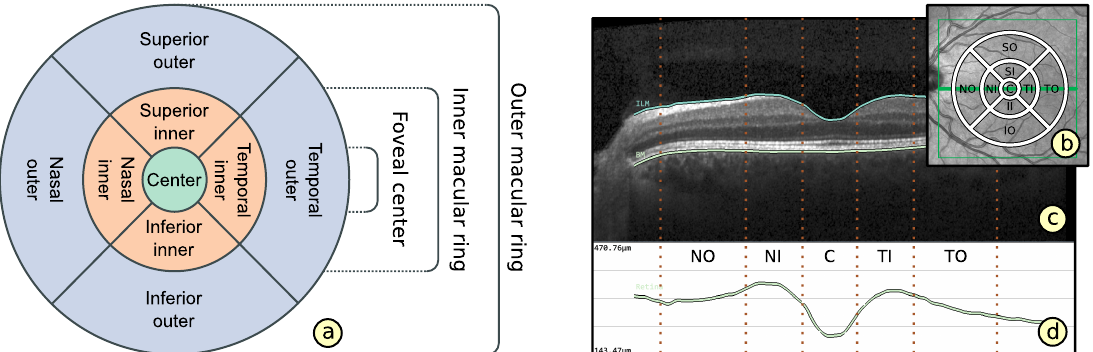
Figure 1. The layout of the standard ETDRS grid. The ETDRS grid cells divide the retina into nine regions defined by three rings and four quadrants ( a ). An overview shows the grid on top of a fundus image of a healthy left eye ( b ). The location of a B-scan is marked (central green line). A detail view shows the B-scan ( c ), segmented layer boundaries of total retina, and the layer thickness as a line chart ( d ). The dotted lines denote anatomically distinct areas along the image axis.